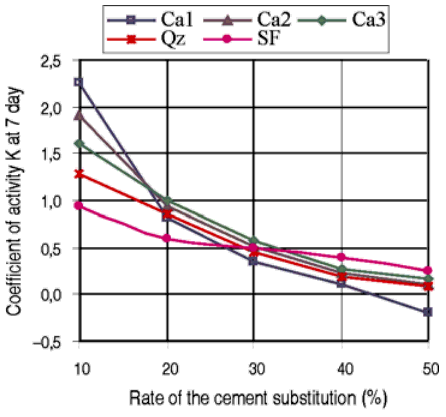
Fig 8. Evaluation of the coefficient of activity in 7 days, calculated on the basis of the predictive model of Feret according to the cement substitution rate